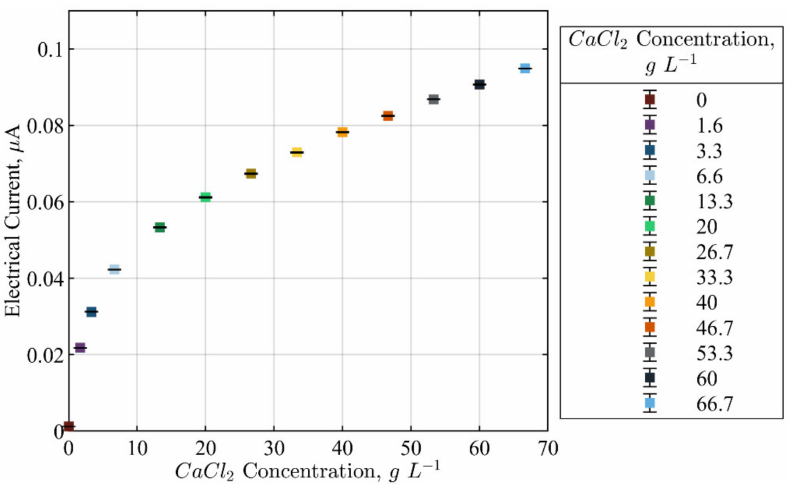
Figure 15. Average electrical current measurements evaluated for 100 frames for different concentra- tions of CaCl 2 solutions with no stirrer motion.